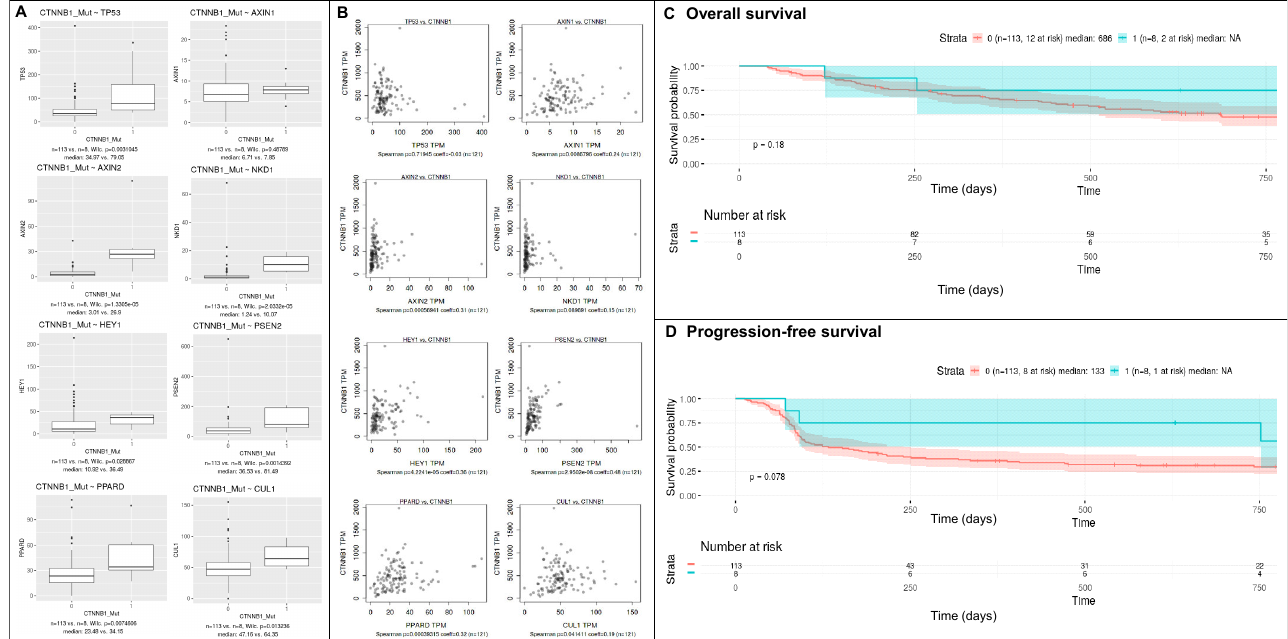
Figure 3. Transcriptomic expression of hallmark Wnt/ β‐ catenin signaling pathway genes in CTNNB1 ‐ mutant versus non ‐ mutant melanoma patients treated with anti ‐ PD1 monotherapy ( A ). Gene expression was measured in transcripts per million (TPM). Wilcoxon sum rank test was used for comparison. Spearman correlation of transcriptomic gene expression of CTNNB1 (y ‐ axis) and hallmark Wnt/ β‐ catenin signaling pathway genes ( B ). Overall ( C ) and progression ‐ free survival ( D ) in CTNNB1 ‐ mutant compared to non ‐ mutant melanoma patients treated with anti ‐ PD1 monotherapy. Survival was measured in days.